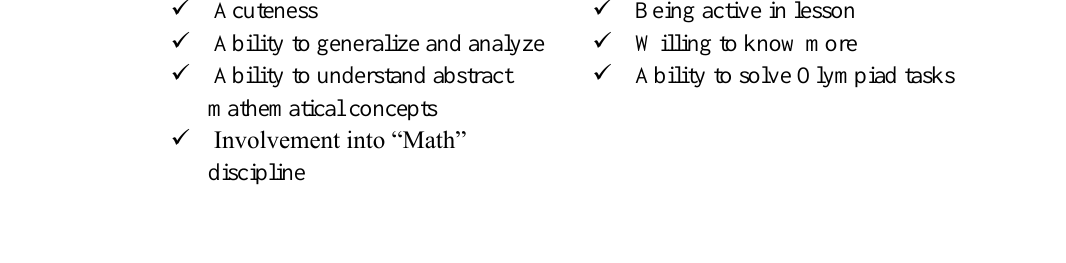
Table 4. Students 'answers to the question “How can you develop your math abilities?” 3 rd year